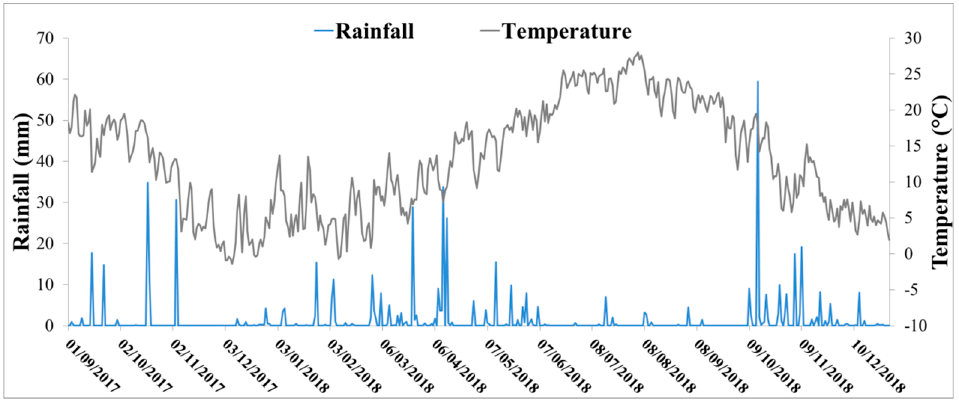
Figure 2. Precipitation and temperature records for a local meteorological station in Tornabous of the interior plain of Catalonia, Spain.